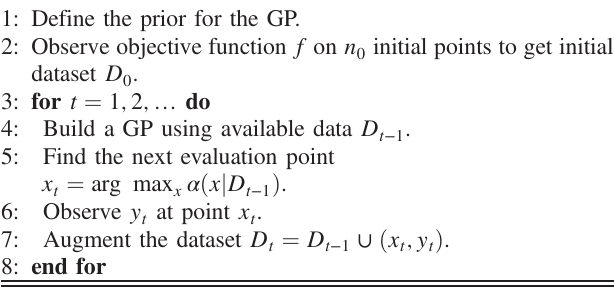
Algorithm 1 Bayesian optimization algorithm.